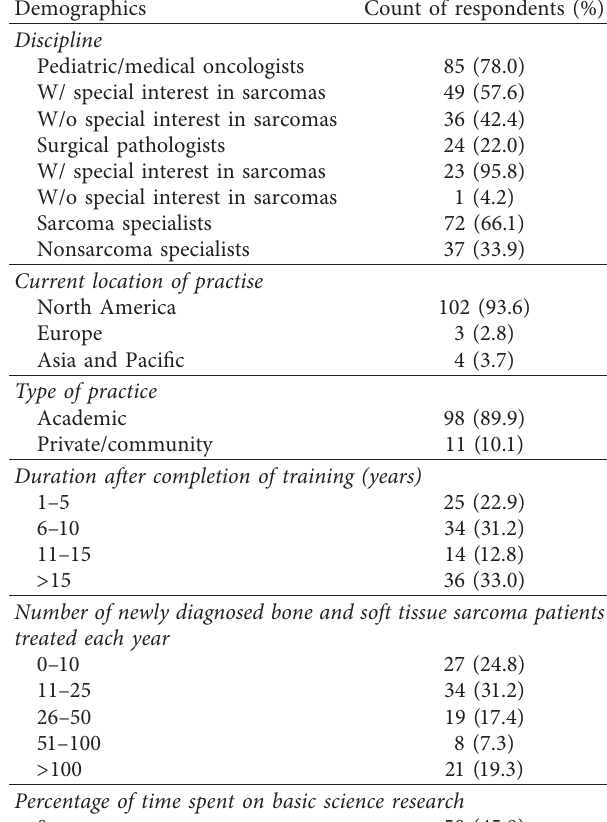
Table 1: Demographics of